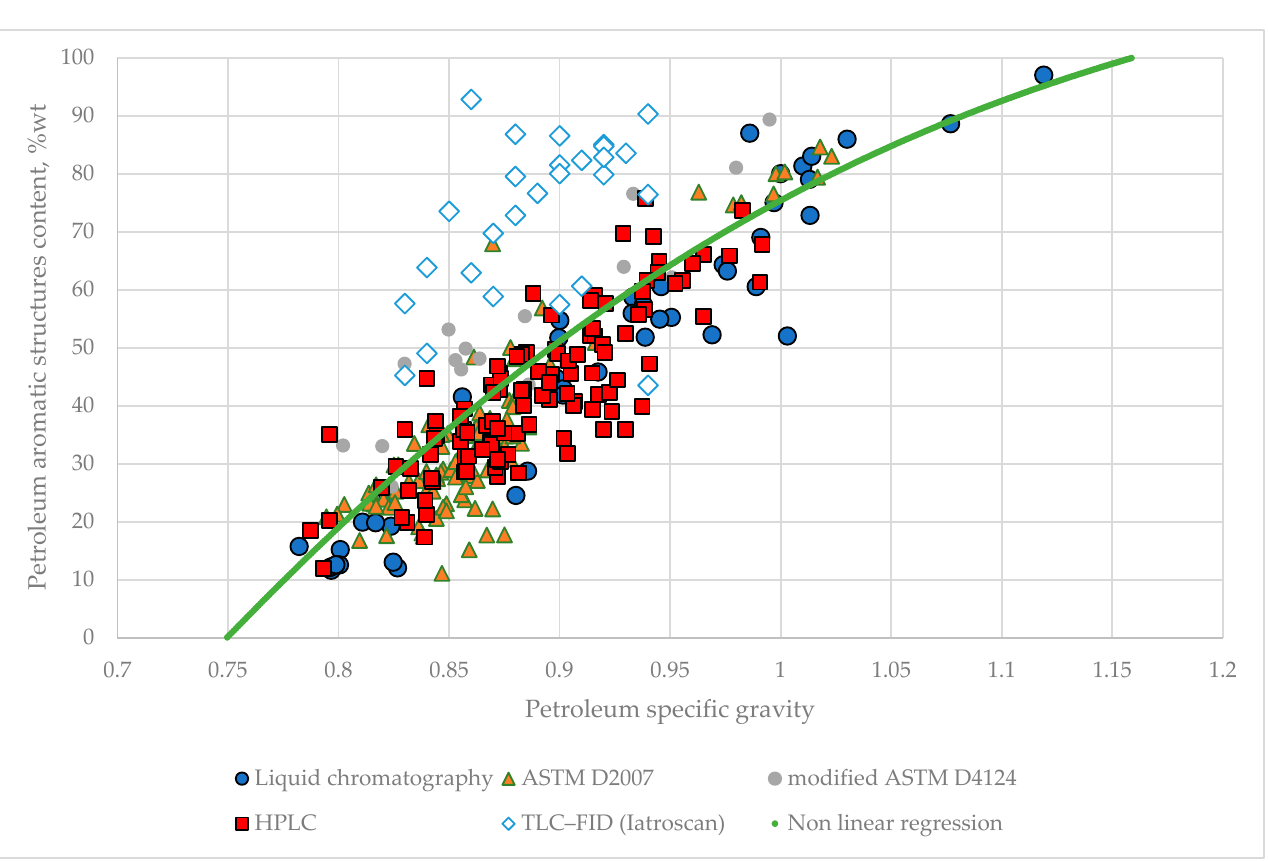
Figure 7. Dependence of petroleum aromatic structures content on specific gravity.